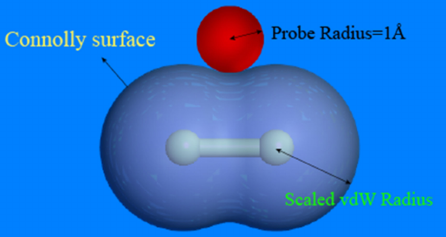
Figure 7. Connolly surface of chlorine molecule (reprinted from